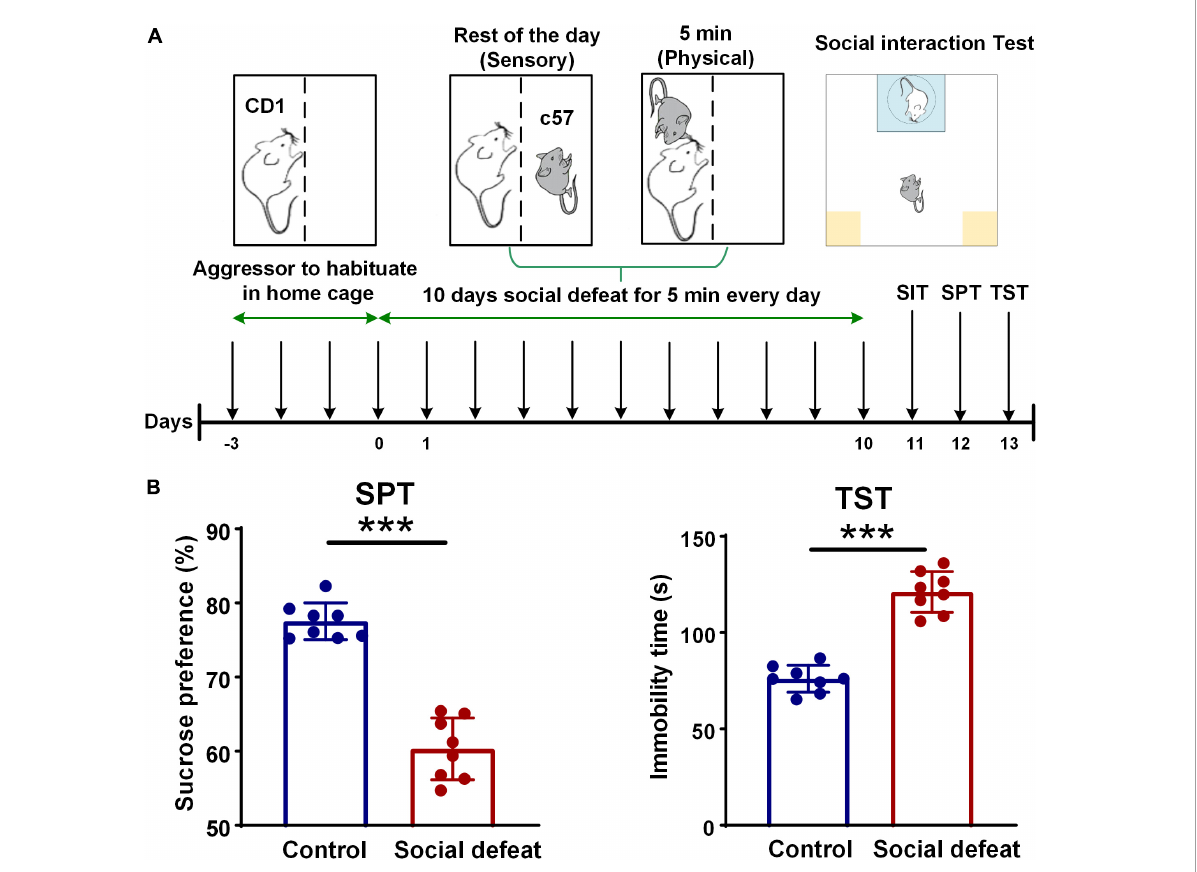
FIGURE1 Schematic for CSDS paradigm and quality assessment of the social defeat model. (A) Experimental timeline showing all the steps of the experimental manipulations. (B) Quality assessment of the social defeat model (control, n = 8 mice; social defeat, n = 8 mice). In the SPT, the socially defeated mice showed a significant decrease in sucrose preference, compared with the control group (control: 77.5475 ± 0.8685; social defeat: 60.3250 ± 1.2877; unpaired t-test, t = 10.04, *** p < 0.001). In the TST, longer immobility time was found in the socially defeated mice, compared with controls (control: 76.0125 ± 1.9551; social defeat: 121.1125 ± 3.6877; unpaired t-test, t = 10.06, *** p <